Question: Summarize what this figure shows in one sentence.
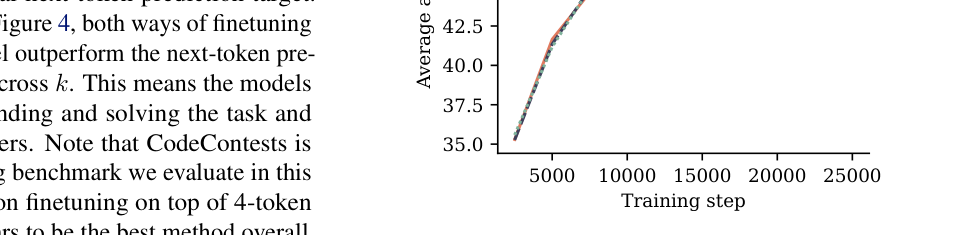
Answer: Multi-token training with 7B models doesn’t improve performance on choice tasks. This figure shows the evolution of average accuracy of 6 standard NLP bench- marks. Detailed results in Appendix G for 7B models trained on 200B tokens of language data. The 2 future token model has the same performance as the baseline and the 4 future token model regresses a bit. Larger model sizes might be necessary to see improvements on these tasks.